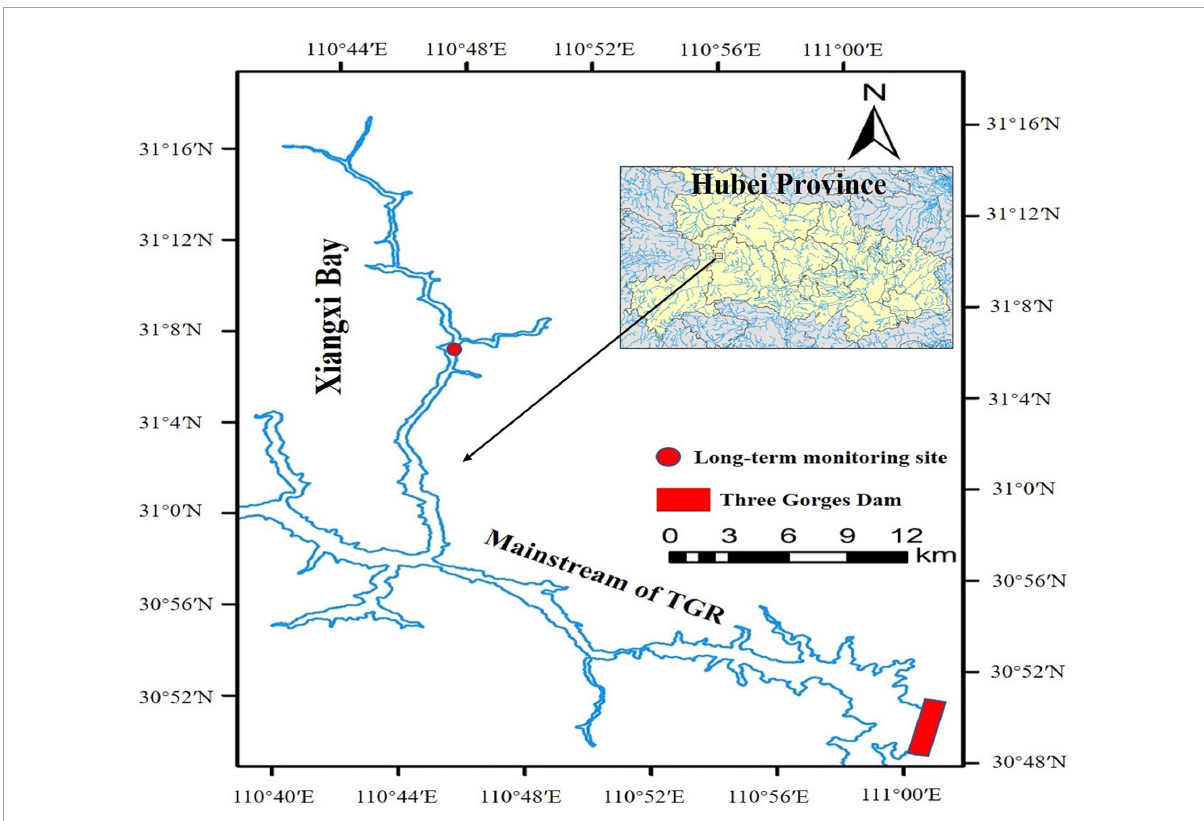
FIGURE1 Geographical location of sampling site in the Xiangxi Bay of Three Gorges Reservoir